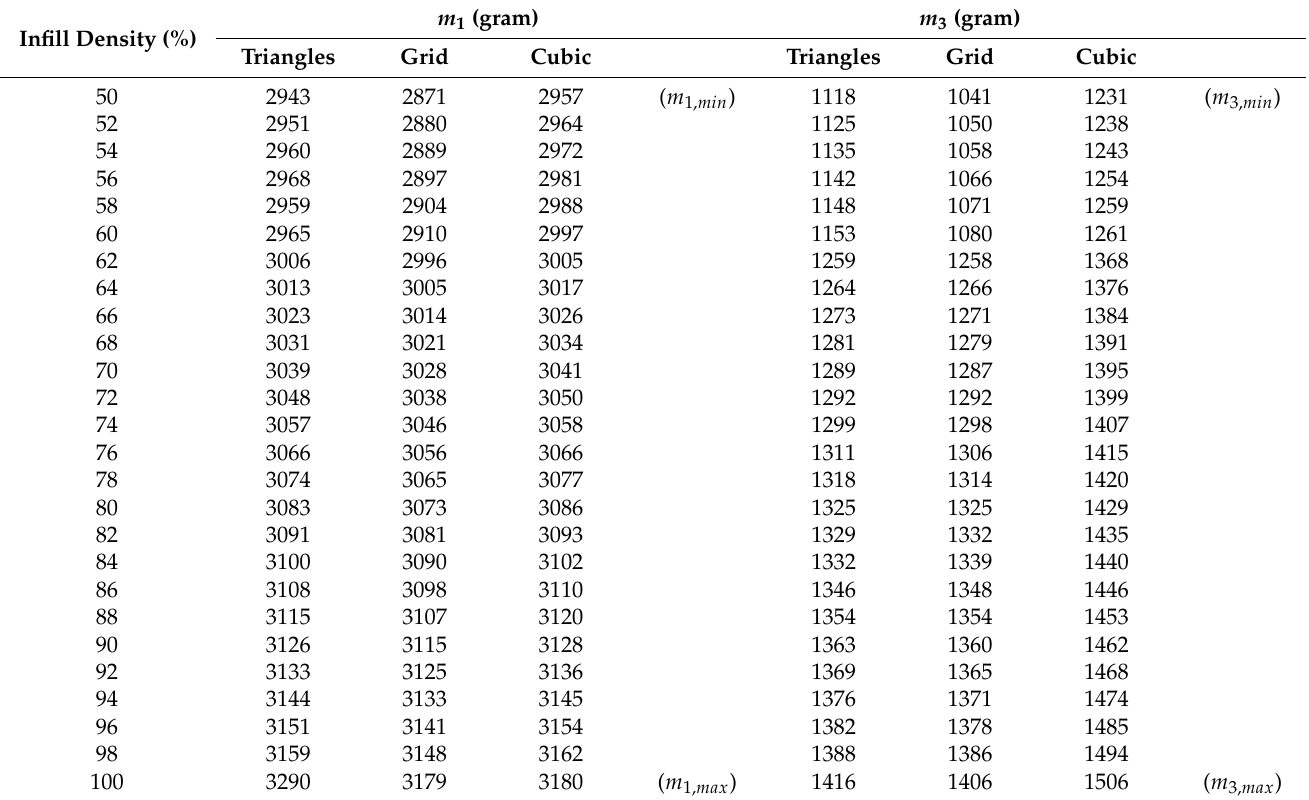
Table 3. Link mass values considering infill density and pattern of the prosthesis shell structure.